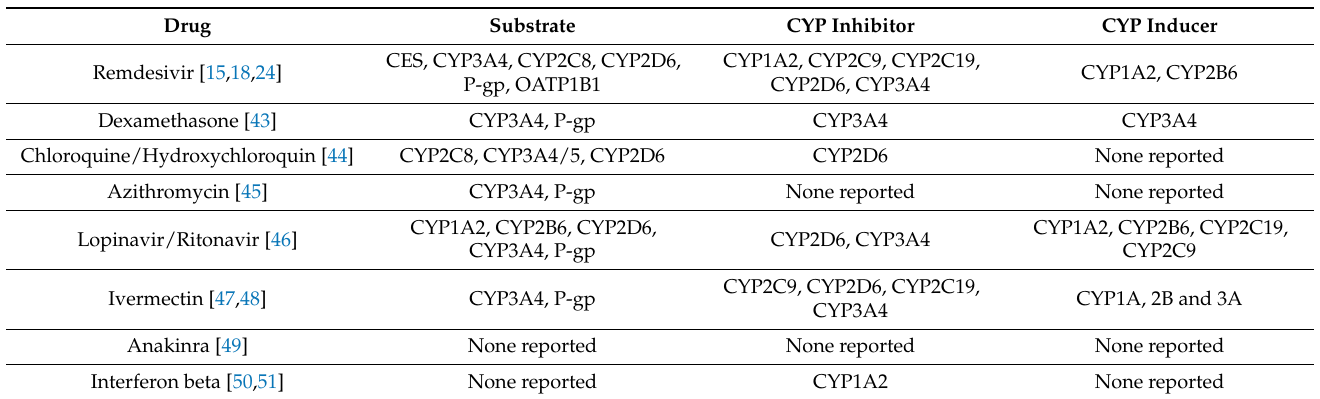
Table 1. COVID-19 drug regimens and their classification as CYP inhibitors and inducers.